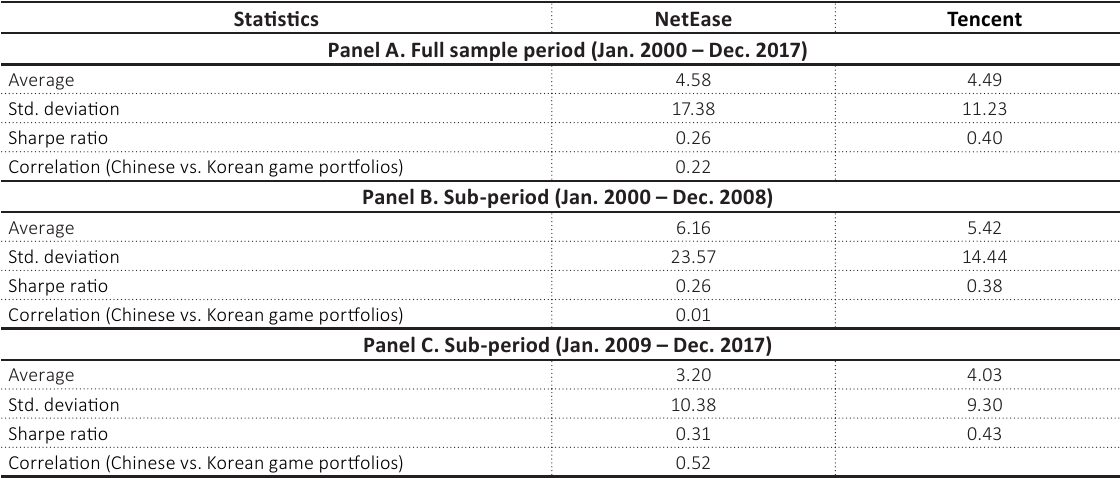
Table 8. Monthly performance of NetEase and Tencent